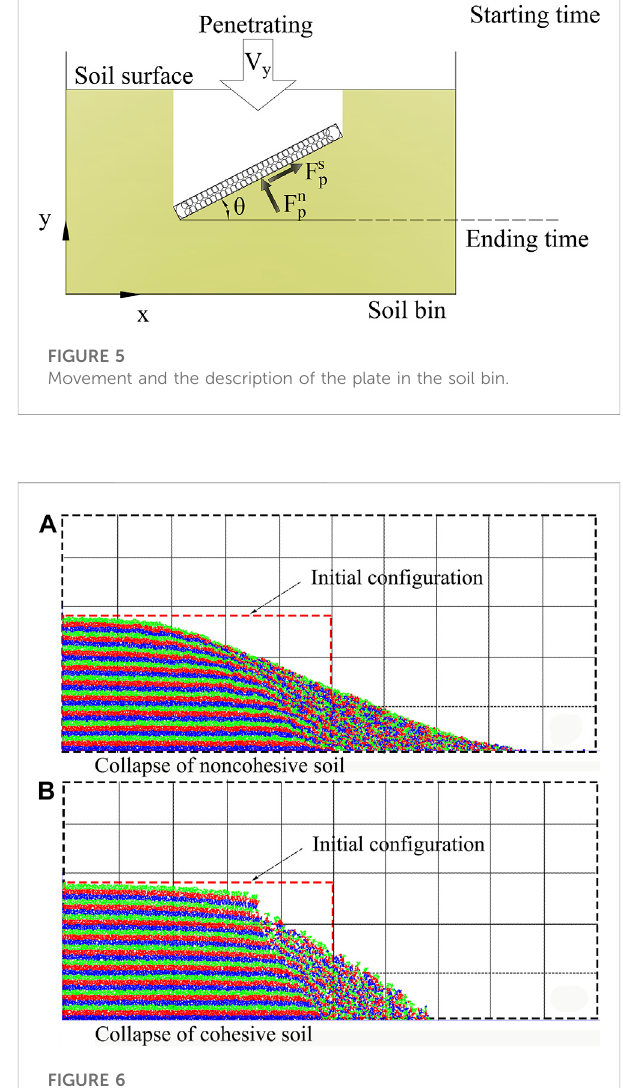
FIGURE 6 Behaviour of soil according to the DEM simulation. (A) Collapse of noncohesive soil. (B) Collapse of cohesive